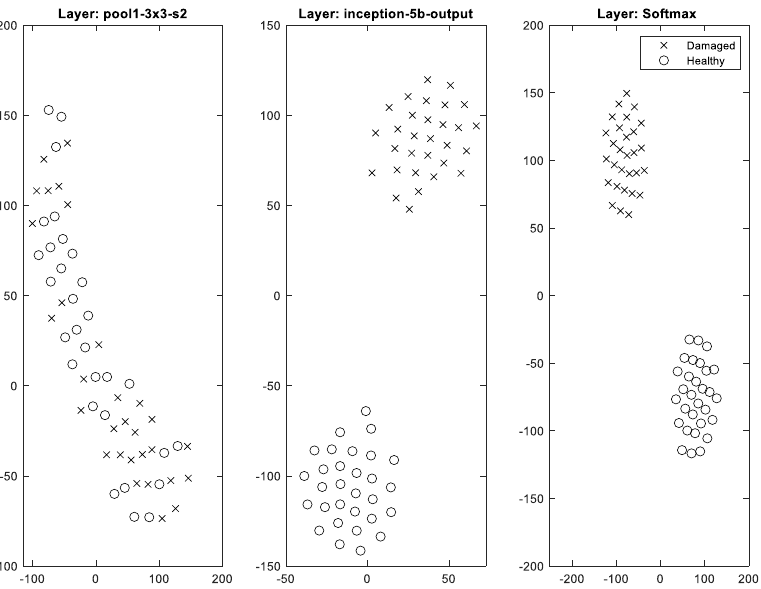
Figure 11. An example of network behaviour from first pooling activation layer to final softmax activations.